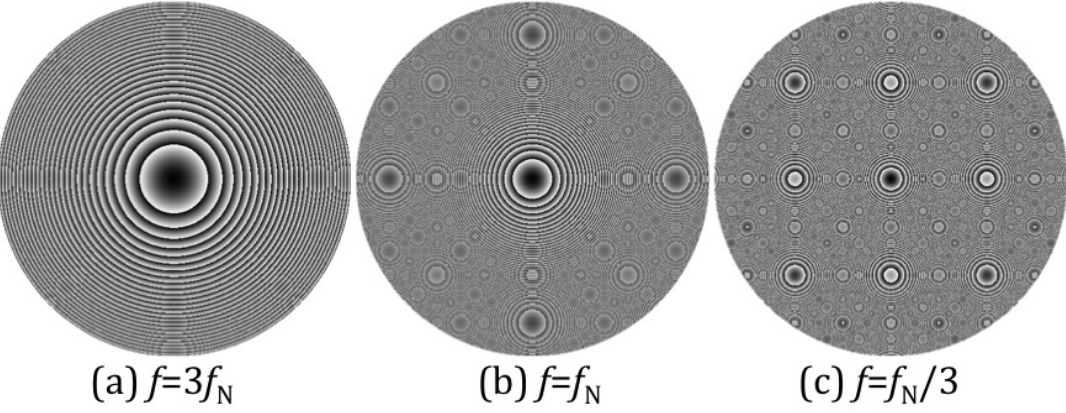
Figure 2. Phase patterns for diffractive lenses having focal lengths of ( a ) 3 f N , ( b ) f N and ( c ) f N /3.